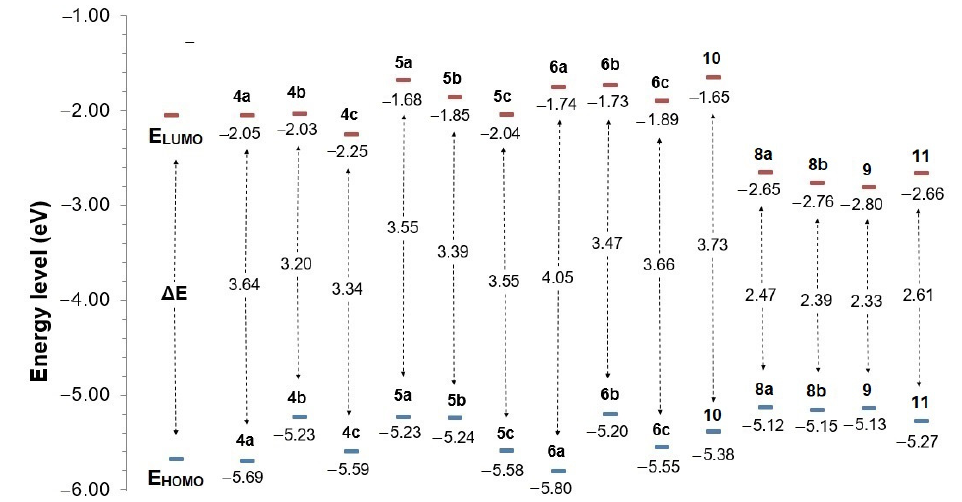
Figure 8. Diagram on HOMO and LUMO energy levels of quinazolin-4(3 H )-ones 4a–c , 5a–c , 6a–c , 10 and 4-cyanoquinazolines 8a,b , 9 , 11 in gas phase.